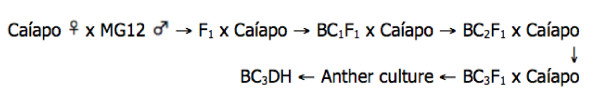
Development scheme of the population of BC3DH lines derived from Caíapo (O. sativa) × MG12 (O. glaberrima) interspecific cross.